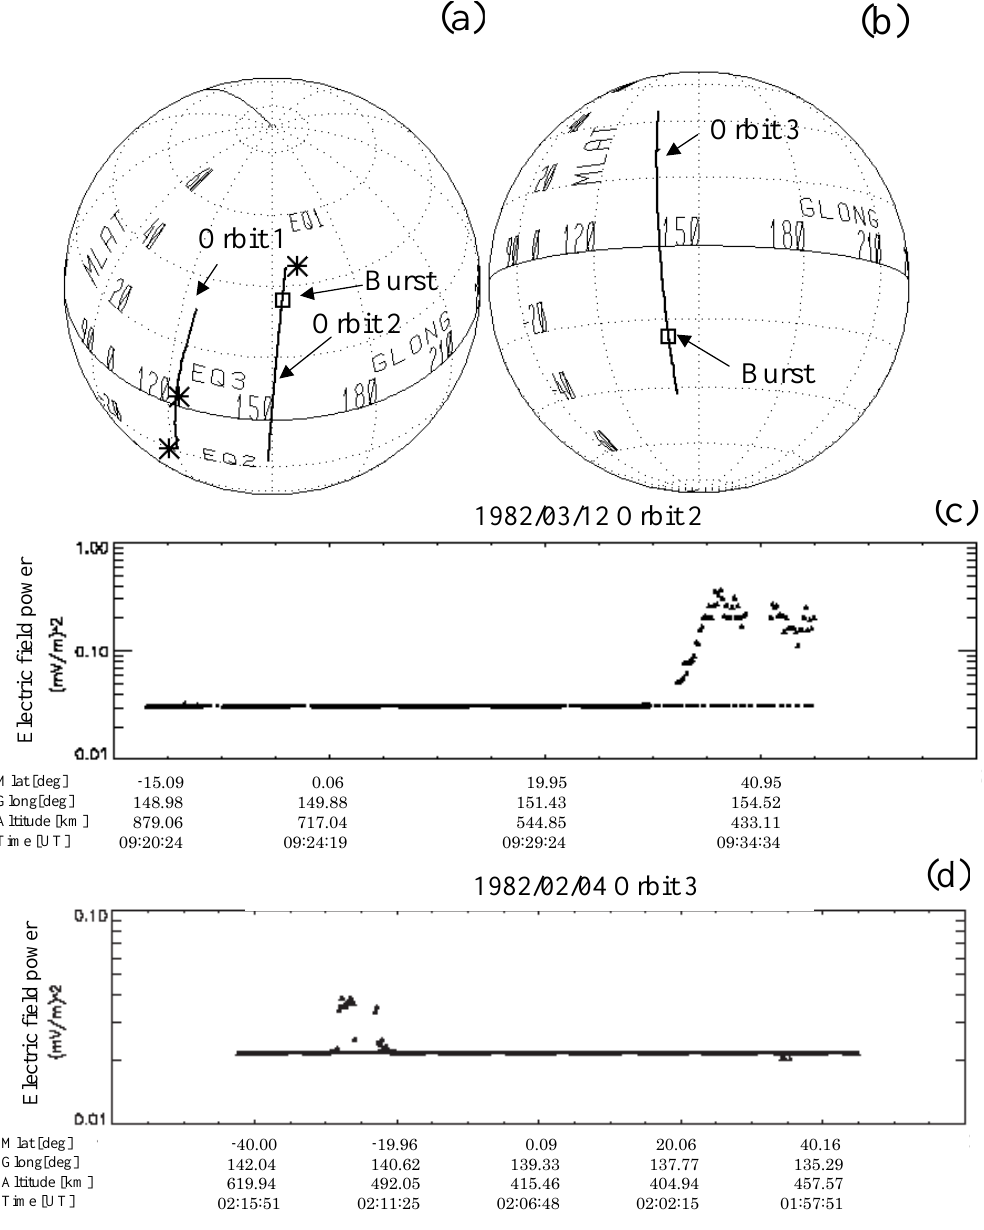
Fig. 4. Examples of satellite orbits and observed burst events in the electric field. ( a ) Two satellite orbits (orbit 1 and 2) on 12 March 1982 and major seismic events near the orbits are marked by an asterisk (*), while the approximate location of the burst event in the trajectory is marked by a square. ( b ) Same format as (a) for the orbit 3 on 4 February 1982 but no major earthquake is detected and the burst is observed. ( c ) Horizontal electric field power variation along the orbit 2 shown in (a). The intensive burst observed around 35 ◦ N in the magnetic latitude with major earthquake nearby. ( d ) Same format as (c) but the burst event without major earthquakes. Orbit 1 has two major earthquakes nearby but no burst is